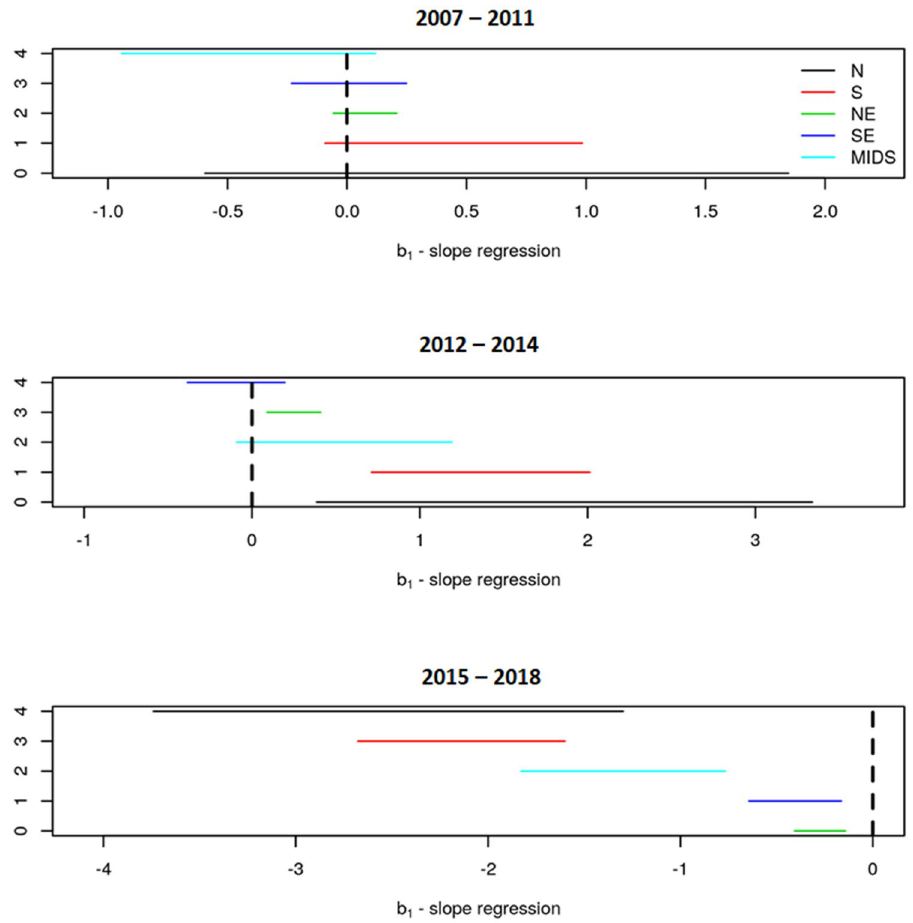
Figure 4:. 90% confidence interval for angular coefficients of Brazilian regions, from 2007 to 2011, 2012 to 2014, and 2015 to 2018. The five regions of Brazil are represented as North (N), Northeast (NE), Midwest (MIDS), South (S) and Southeast (SE). This figure was created by using the R software 19 version 3.5.3 (https:// www.R- proje ct. org/).